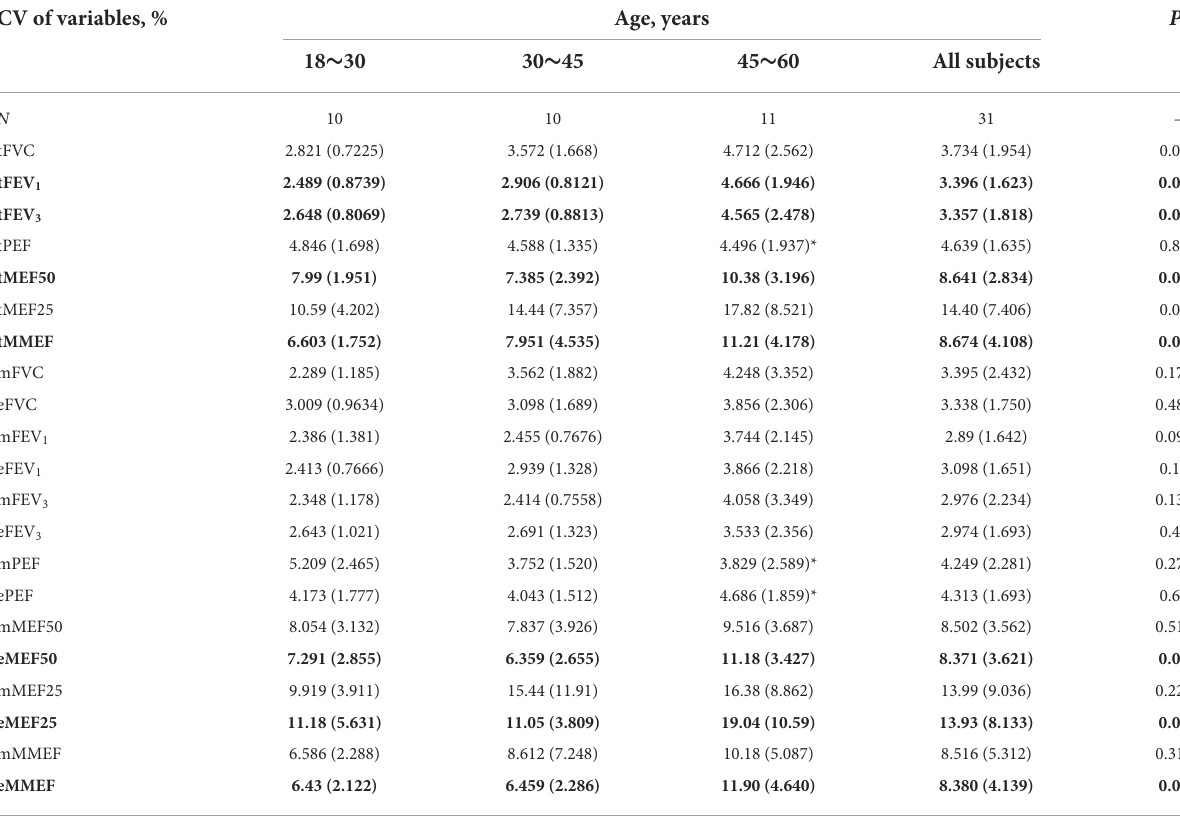
FVC,forcedvitalcapacity;FEV 1 ,forcedexpiratoryvolumein1s;FEV 3 ,FEVin3s;MEF50:forcedexpiratoryflowat50%offorcedvitalcapacity;MEF25,forcedexpiratoryflowat75%of